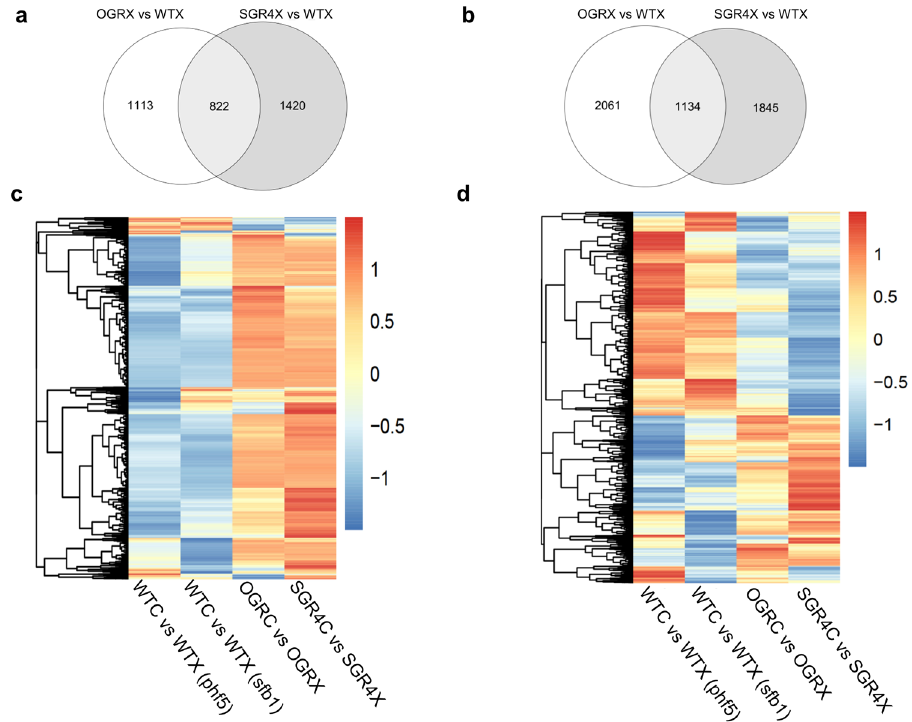
Fig. 5 SF3B1- and PHF5A-regulated genes and AS events displayed signi fi cant overlap. Overlap of DEGs a and DAS events b of GEX1A-responsive gene between SGR4 and OGR. Heatmap and hierarchical clustering of log2FC of DEG. Heatmap and hierarchical clustering of log2FC of DEG c and delta Ψ (change in splicing) of each intron-retention event d signi fi cantly affected by GEX1A in WT_sfb1, WT_phf5, SGR4, and PHF5 overexpressing line (OGR). WT of the SF3B1 (WT_sfb1) and PHF5A (WT_phf5).